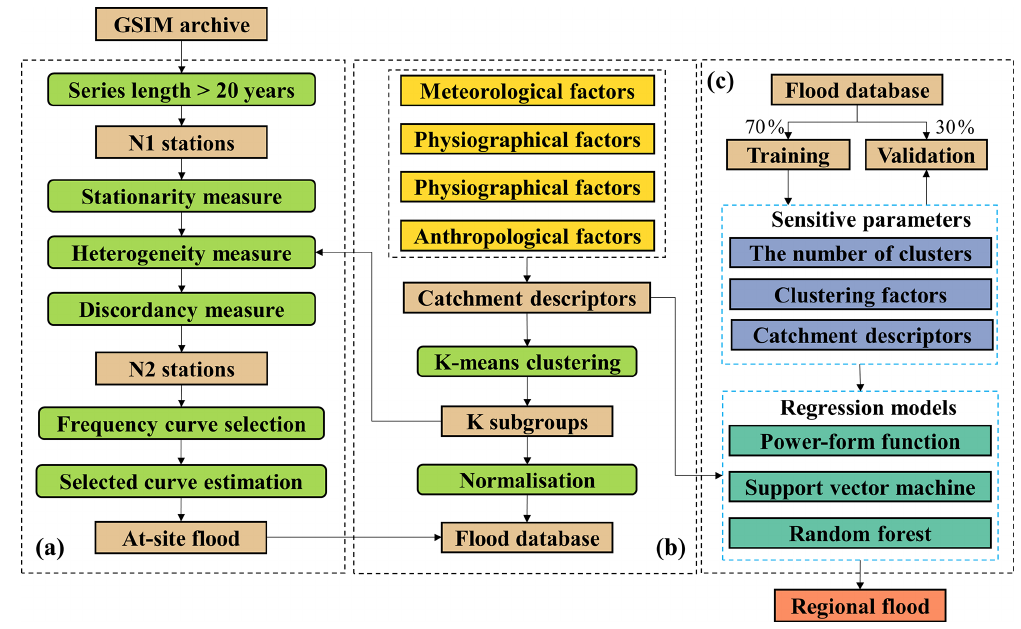
Figure 2. The framework of this research. (a) At-site flood estimation; (b) subgroup delineation; (c) regional flood